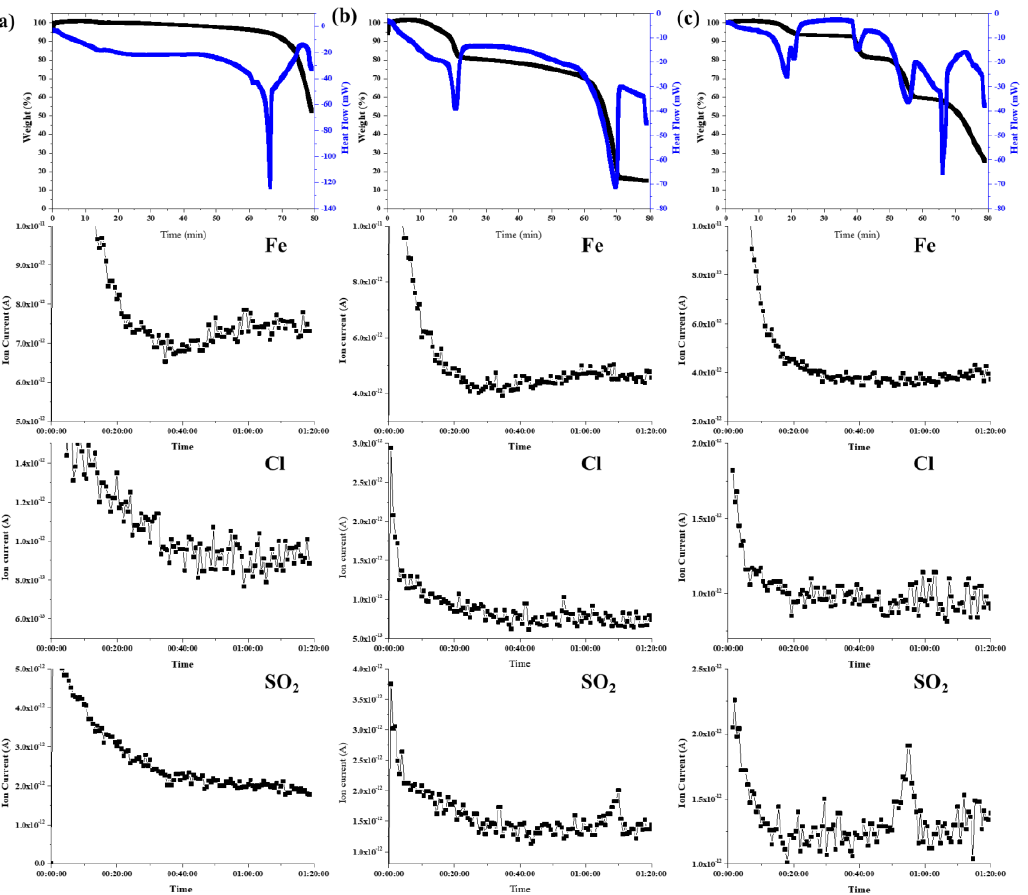
Figure 3. Thermal decomposition of catalyst compound with different R values; ( a ) FeCl 2 , ( b ) Fe 2 (SO 4 ) 3 ·xH 2 O, ( c ) R = 0.17 [xFe 2 (SO 4 ) 3 : (1−x)FeCl 2